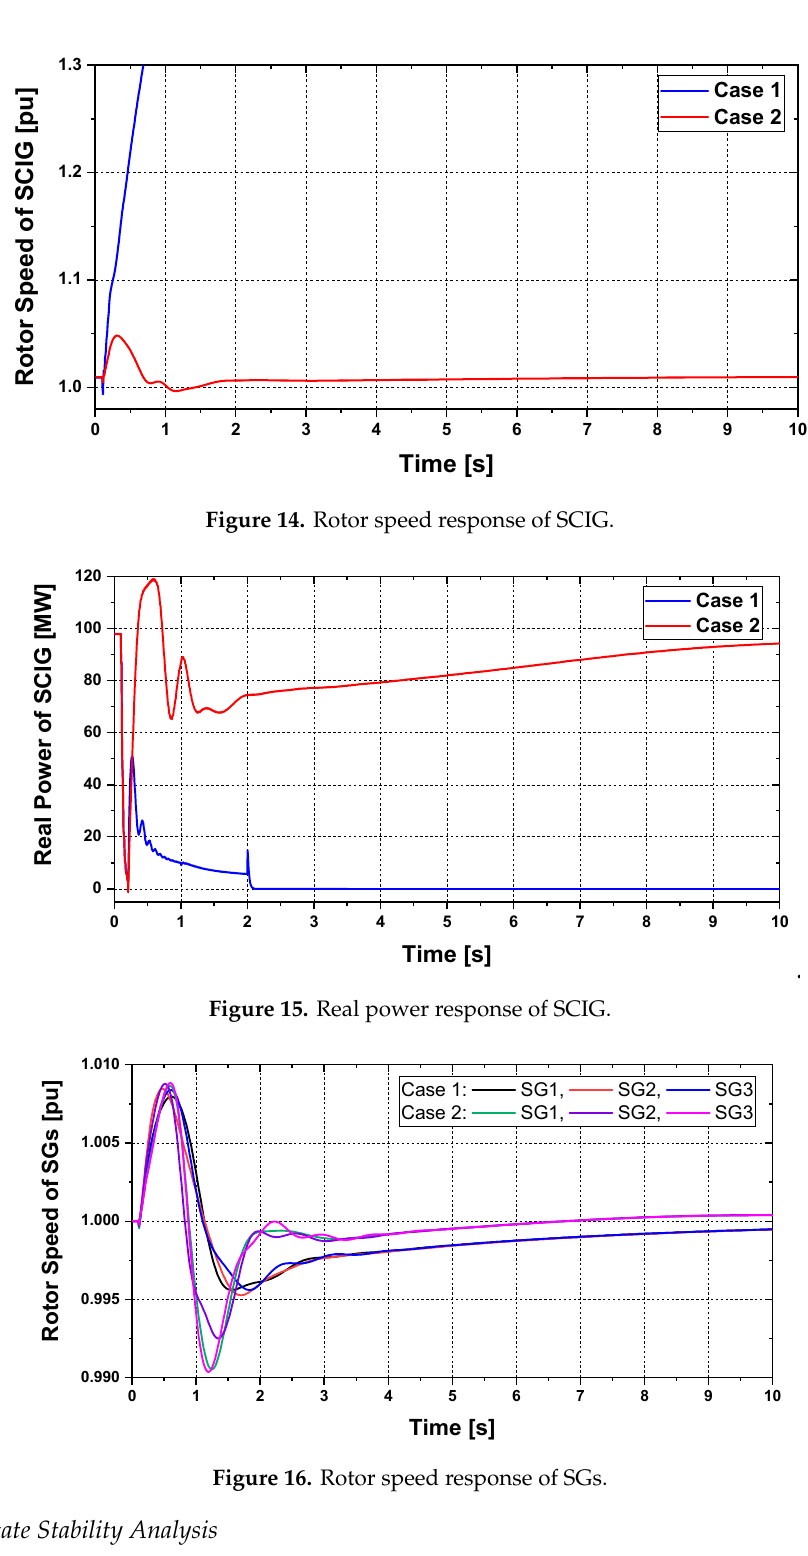
Figure 13. Terminal voltage response of SCIG.